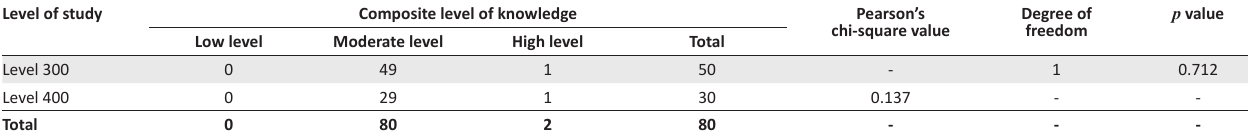
TABLE 4: Chi-square analysis of the association between respondents’ level of study and the level of knowledge on patient safety ( n = 80).